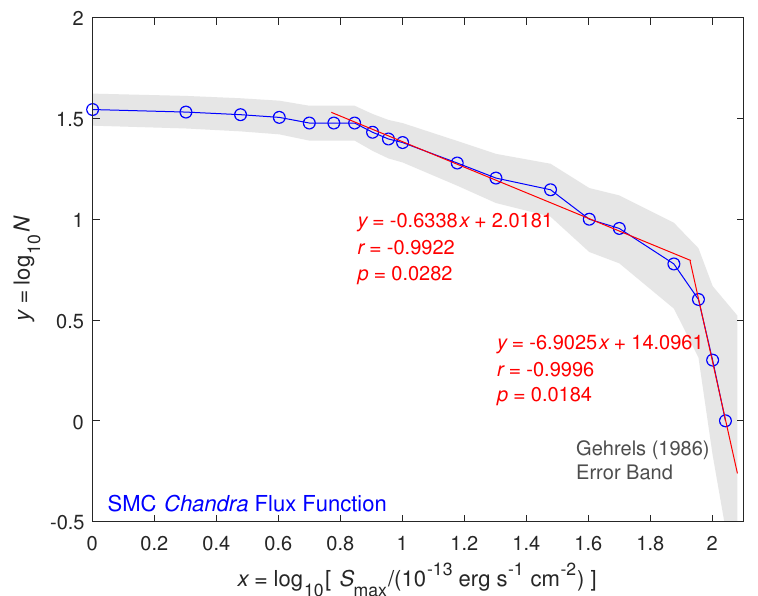
Figure 7. Cumulative number N of SMC Chandra sources above a flux level S max versus S max on logarithmic scales (blue points). The grey area respresents the 1 σ error bars to the data points according to the prescription of [44]. The errors in the best-fit line are listed in Table 3.